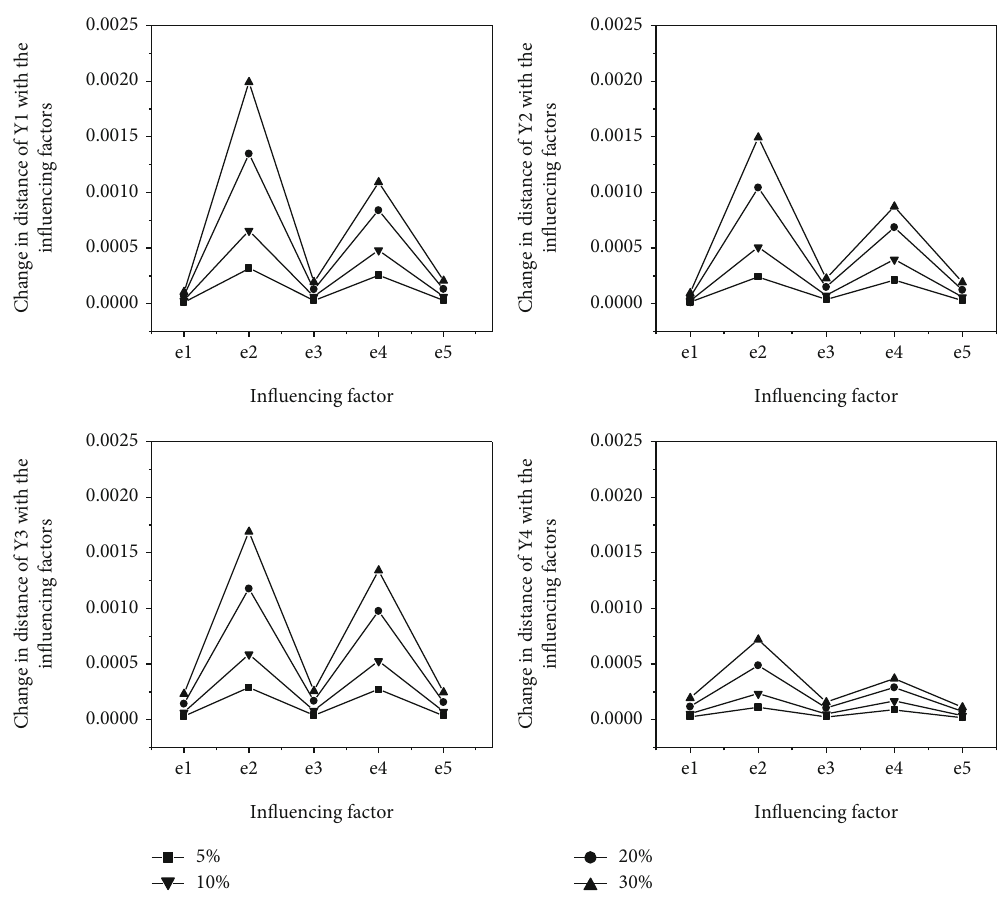
Figure 13: Relative deviations in the safety margins generated by changes in the in fl uencing factors.